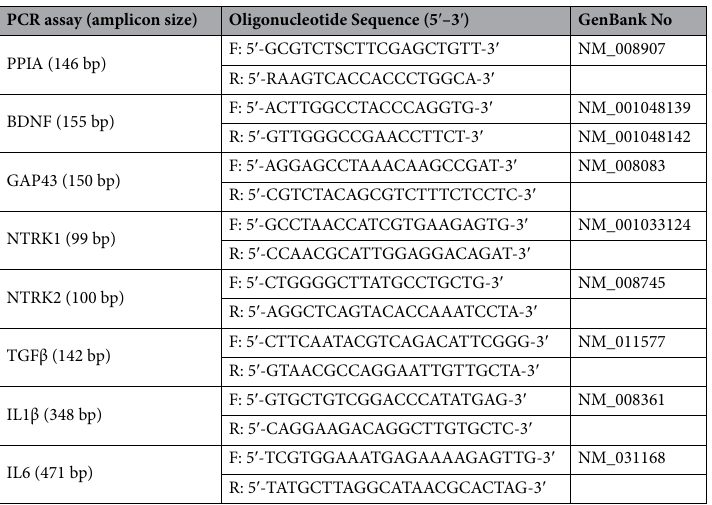
Table 2. Primers for quantitative real-time PCR. Mouse specific primers and probes for qPCR; F forward, R